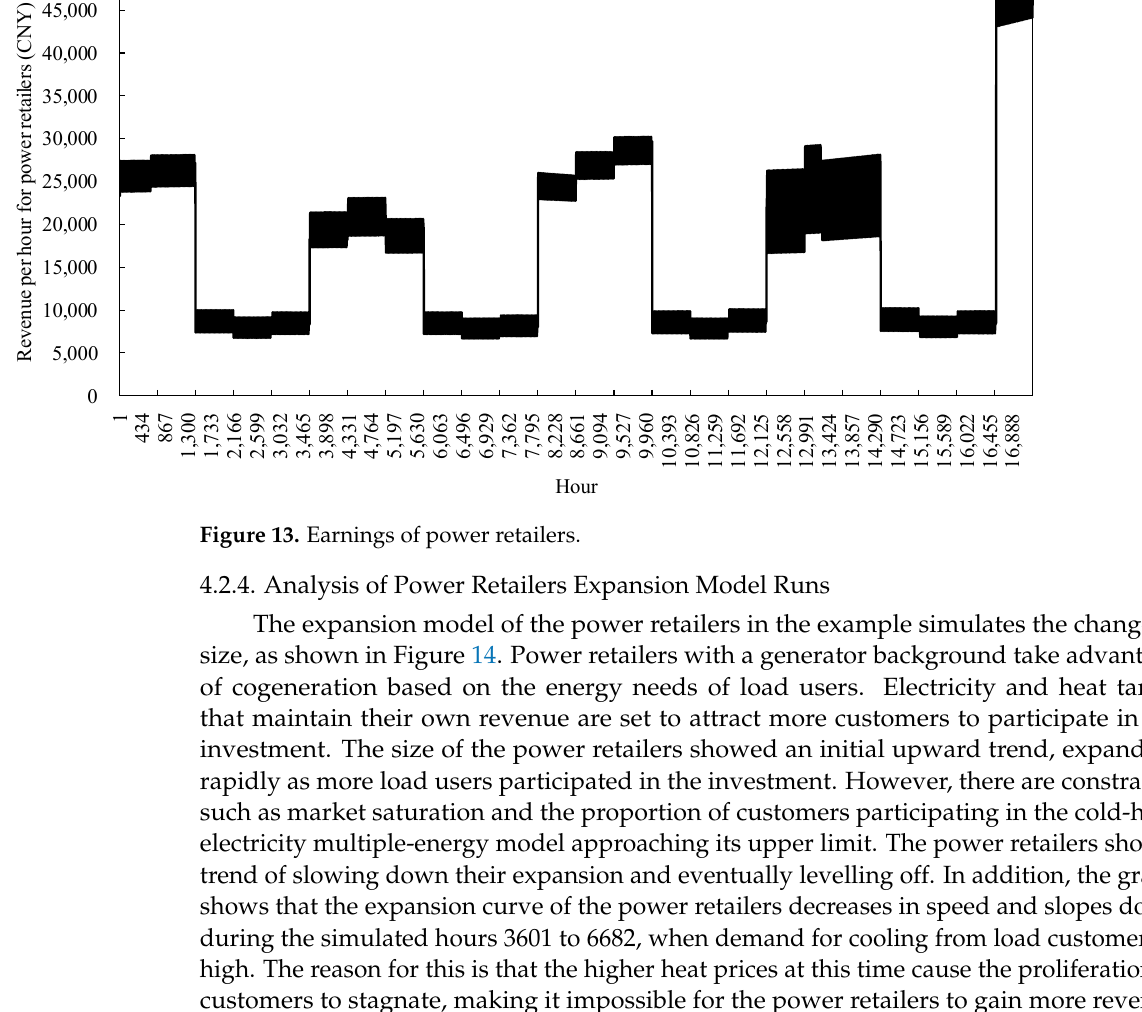
Figure 13. Earnings of power retailers.